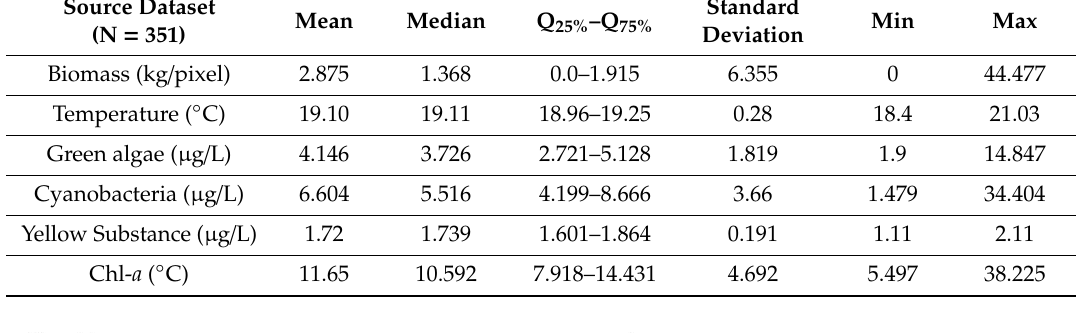
Table 2. Descriptive statistics of Landsat 8 regression tree training dataset.